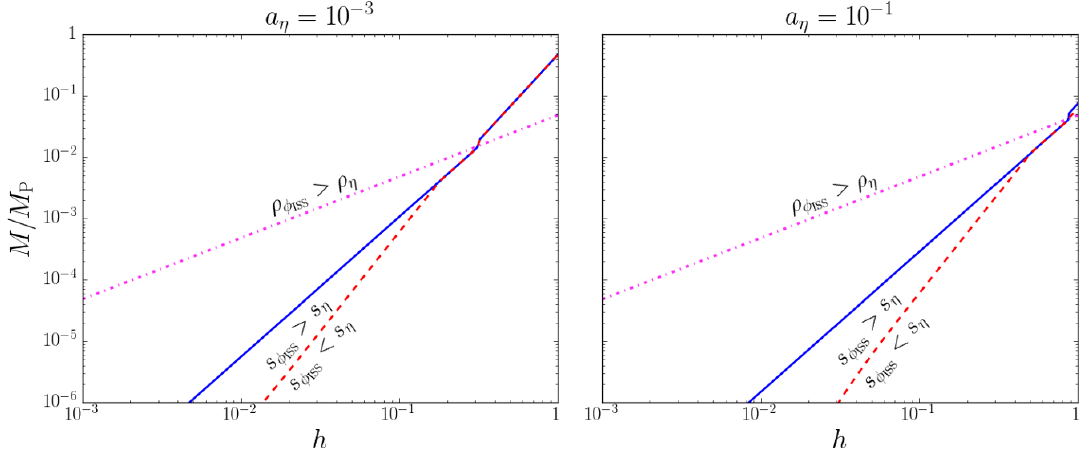
Figure 3 . The curves of s (cid:30) = s (cid:17) numerically obtained from equations (4.33) and (4.35), and ISS the magenta dot-dashed curve (cid:26) (cid:30) = (cid:26) (cid:17) from equation (4.30) for small (large) coupling a (cid:17) = 10 (cid:0) 3 ISS ( a (cid:17) = 10 (cid:0) 1 ). The blue solid curve is evaluated at the decay epoch of decay of S 2 , the last decaying ISS particle as already seen in (cid:12)gure 2, and the red dashed curve is evaluated at the decay time of (cid:31) S 1 , which is the last product to decay | we write legends just for the latter because the one for the blue solid curve has been already given in (cid:12)gure